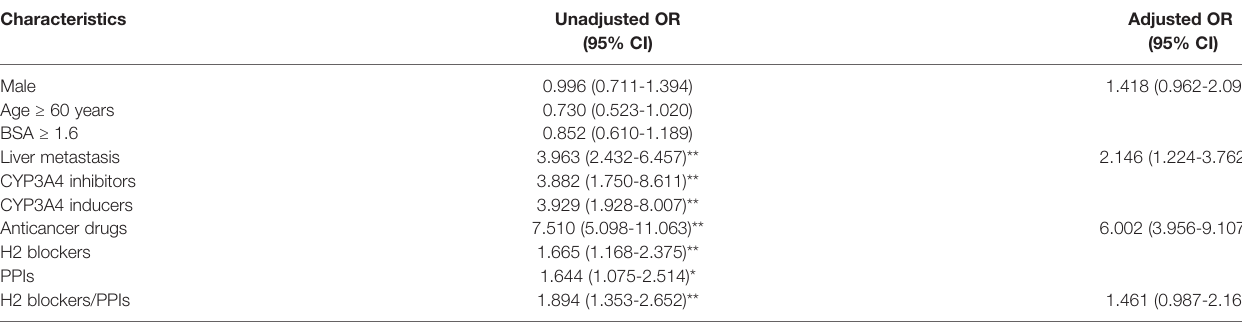
TABLE 2 | Univariate and multivariate analyses to identify predictors for hepatotoxicity related to TKI administration. Characteristics